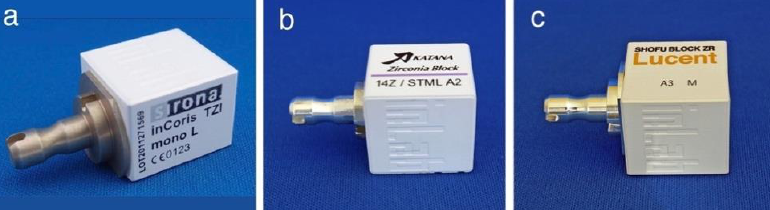
Figure 5. Zirconia CAD/CAM blocks for SpeedFire ® . ( a ) inCoris TZI ® (Dentsply Sirona, 3Y); ( b ) Kat- ana ® Zirconia Block STML (Kuraray Noritake Dental Inc., M5Y); and ( c ) Shofu Block Zr Lucent ® CEREC (Shofu Inc., M4Y). Table 1. Powder characteristics and typical properties of sintered body of zirconia (provided by Tosoh ® Corp. [28,29,31]).